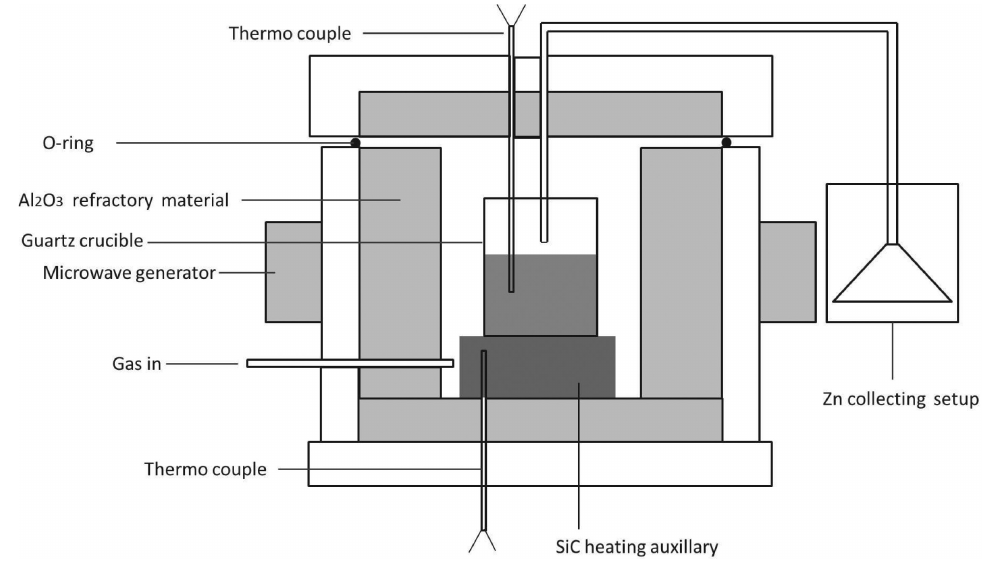
Fig. 1: Schematic diagram of microwave furnace